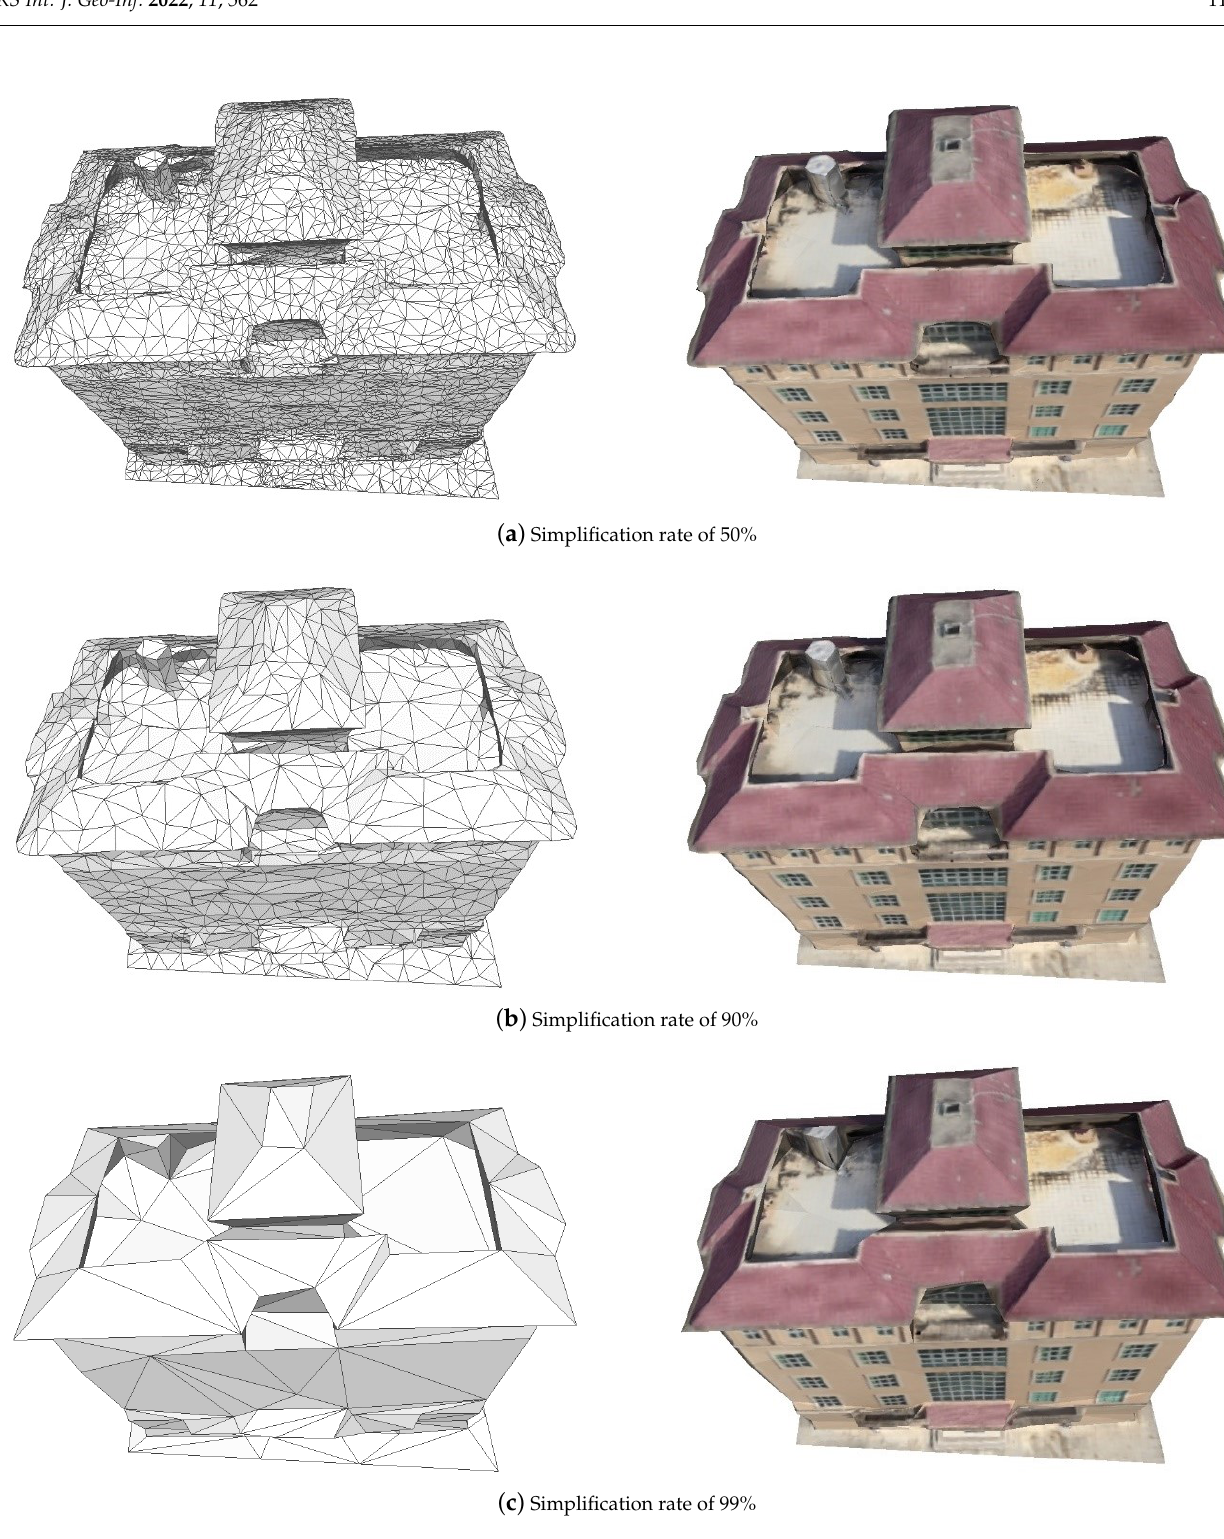
Figure 11. Simplified meshes in our method. ( a ) Simplification rate of 50% (36,841 faces). ( b )